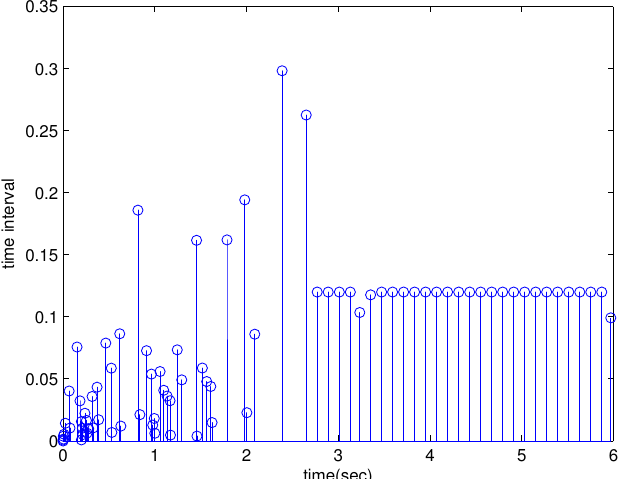
Figure 6. Evolution of the execution time interval (the proposed design method).